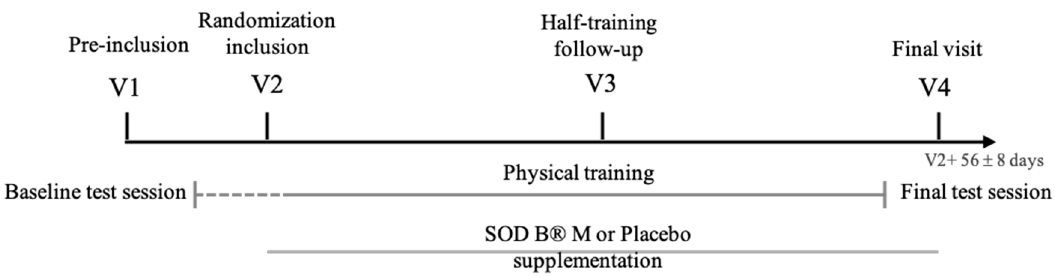
Figure 1. Schematic representation of the clinical study design. V1 includes the Ruffier test, Baseline test session includes the Prevost test, SF 36® survey and Half Cooper test. V2 comprises a blood sampling, V3 includes the Ruffier test, Final test session includes the Prevost test, SF 36® survey and Half Cooper test. V4 includes the Ruffier test and blood